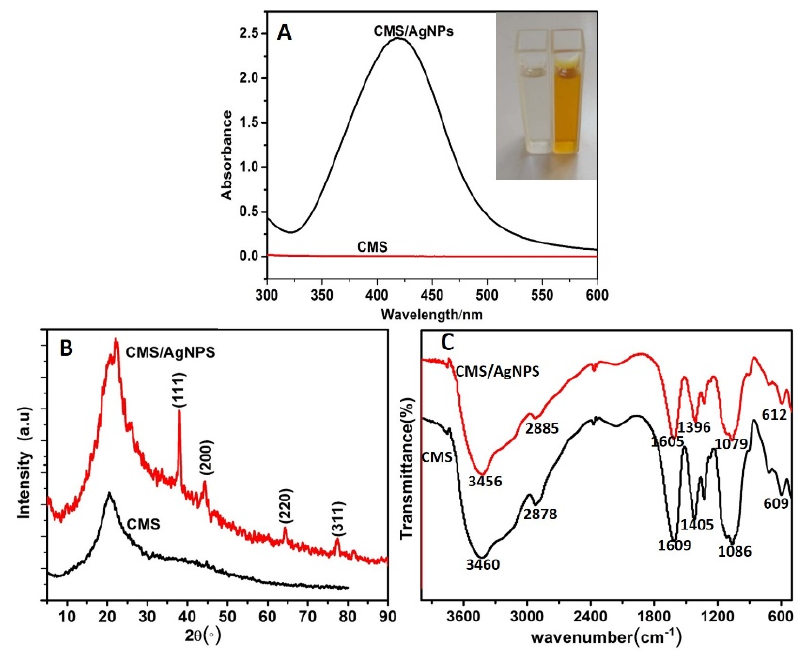
Figure 3. ( A ) UV–VIS spectroscopy, ( B ) XRD pattern, and ( C ) FT-IR spectra of CMS/AgNPs.